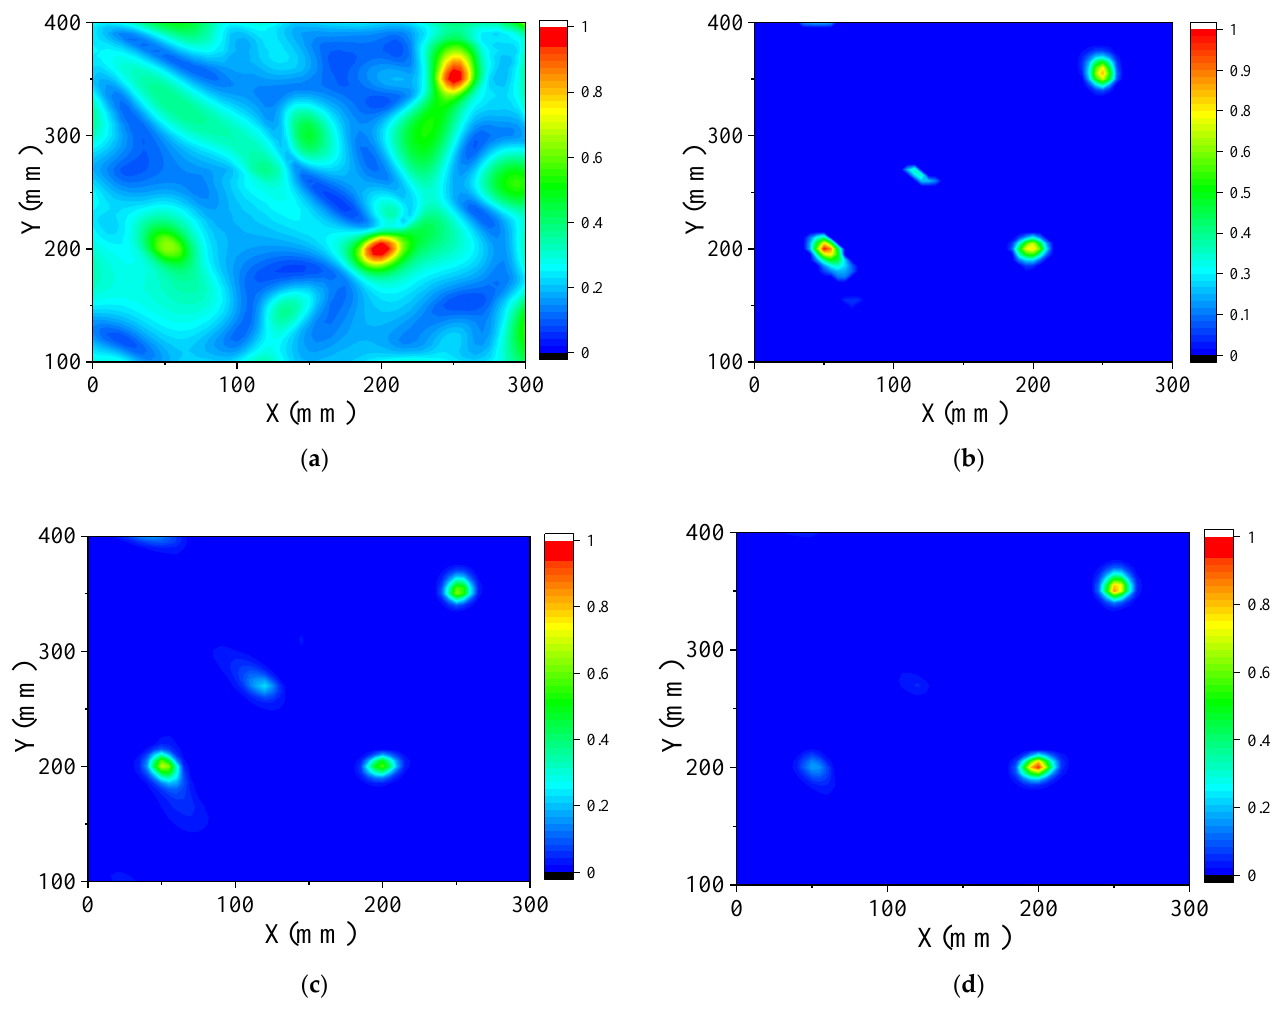
Figure 15. The imaging results of UWB-CS and SI-CS: ( a ) UWB-CS and ( b ) SI-CS with δ = 0.6 and µ = 0.3, ( c ) SI-CS with δ = 0.6 and µ = 0.5 and ( d ) SI-CS with δ = 0.6 and µ = 0.8.